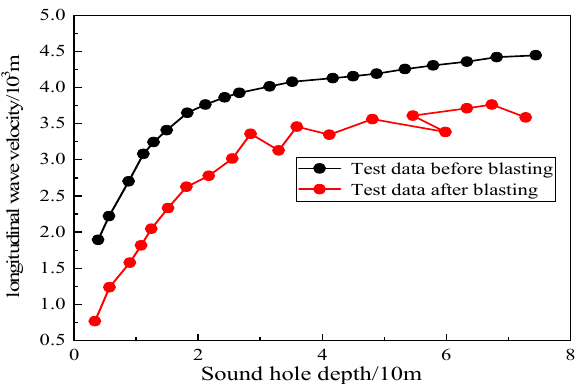
Appl. Sci. 2021 , 11 , x FOR PEER REVIEW